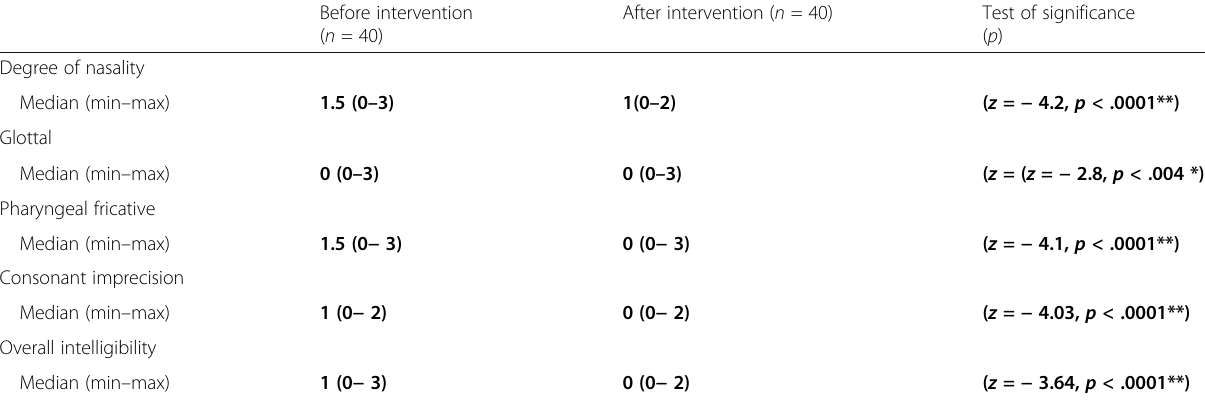
Table 2 Comparison between medians of degree of auditory perceptual assessment of speech before and after intervention Before intervention After intervention ( n = 40) ( n = 40)